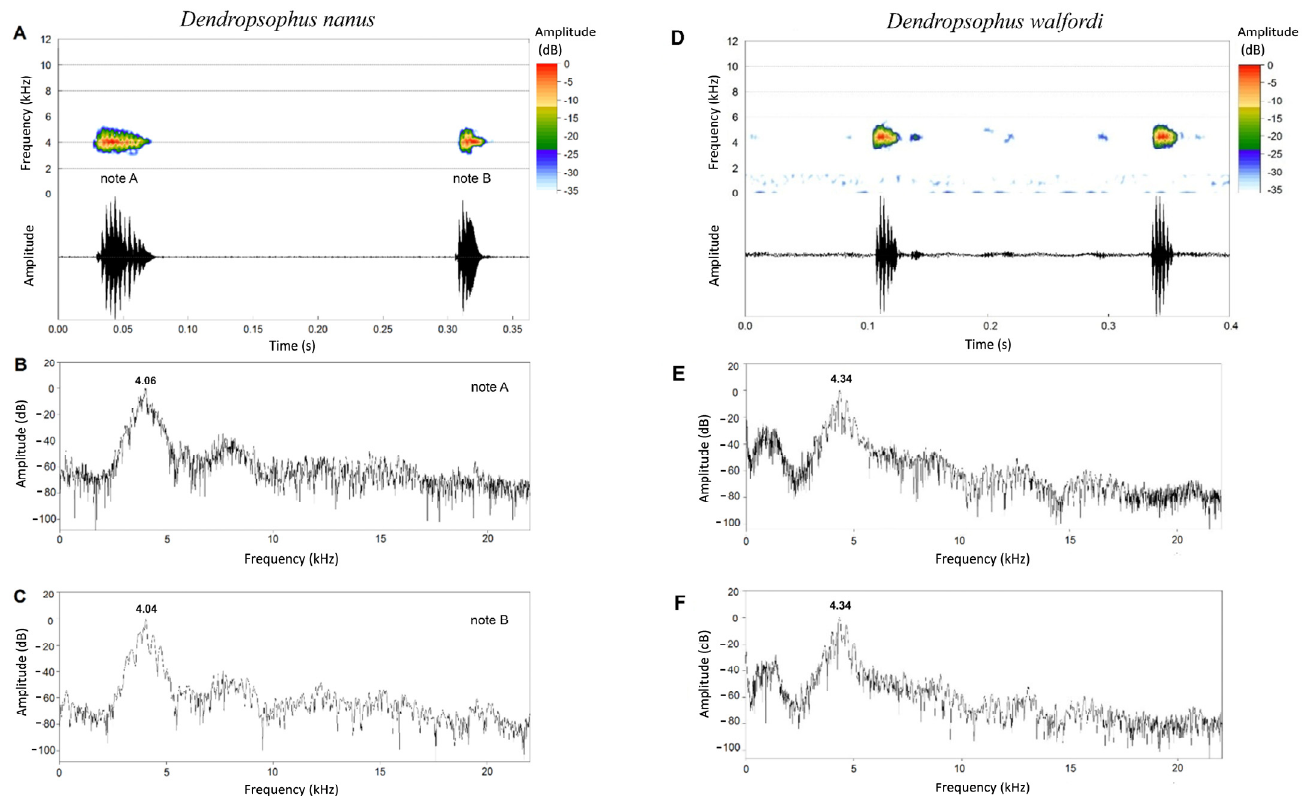
Figure 2. Advertisement calls of topotypical individuals of Dendropsophus nanus ( A – C ) and Dendropsophus walfordi ( D – F ). ( A , D ): Spectrogram (top) and oscillogram (bottom) of two notes in the advertisement call of D. nanus ( A ) and D. walfordi ( D ). Figure ( A ) shows two different notes for D. nanus , the introductory (type A) and the secondary (type B) notes. Figure ( D ) shows an introductory and a secondary note in the advertisement call of D. walfordi , which we considered a single type of note, as they do not differ in acoustic parameters or amplitude modulation (see Results). ( B , C ): Power spectrum of notes A ( B ) and B ( C ) of D. nanus . ( E , F ): Power spectrum of the introductory ( E ) and secondary ( F ) notes of D. walfordi . Sound